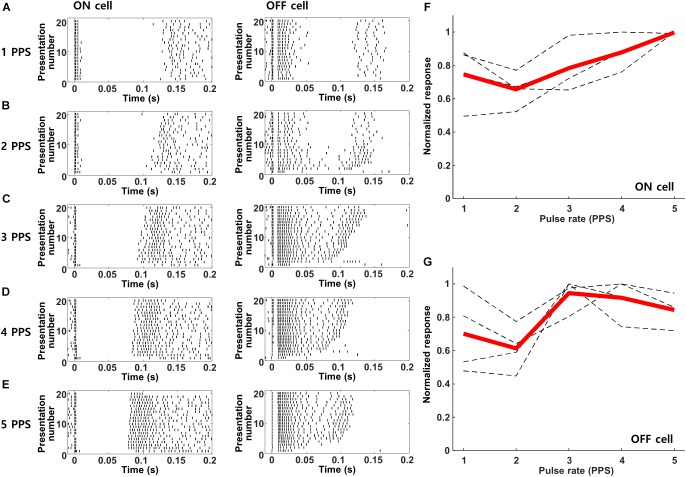
Retinal ganglion cells maintain robust responses to electric stimulation from 1–5 PPS. (A–E) Raster plots of a typical ON (left) and OFF (right) RGC in response to pulse rates of 1–5 PPS (biphasic pulse, cathodal first, 2 ms/phase, 100 μA). (F,G) Normalized response strength of 4 ON and 4 OFF RGCs, respectively. Dotted gray lines are the response curves from individual RGCs average over 20 repeats; thick red lines indicate the average response of each cell type.